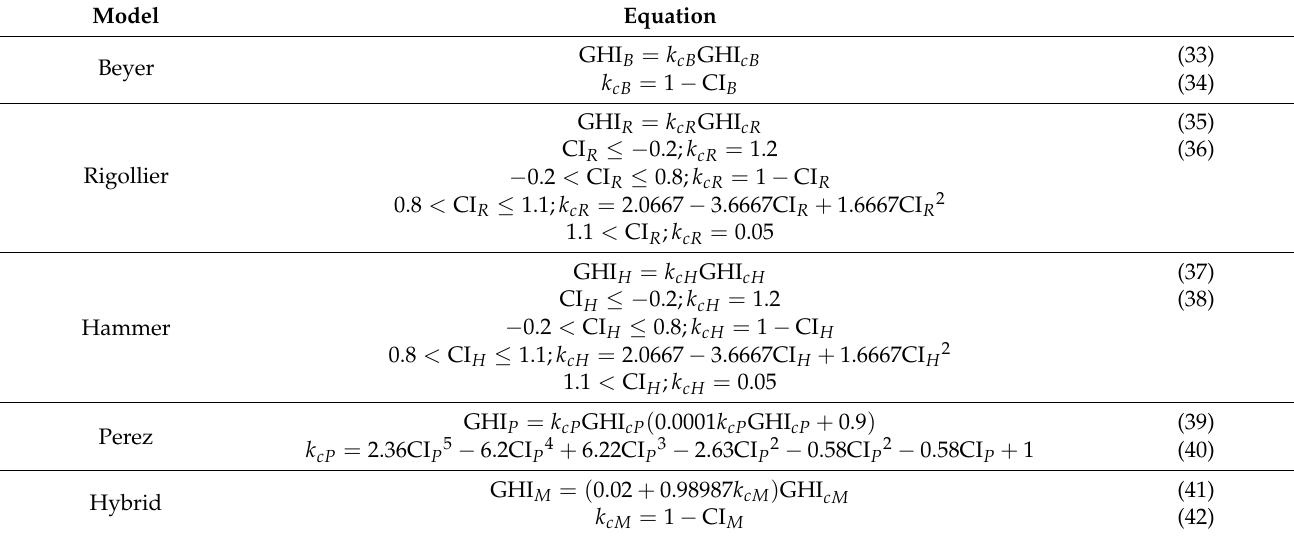
Table 4. Global horizontal irradiance (GHI) conversion used for each semi-empirical